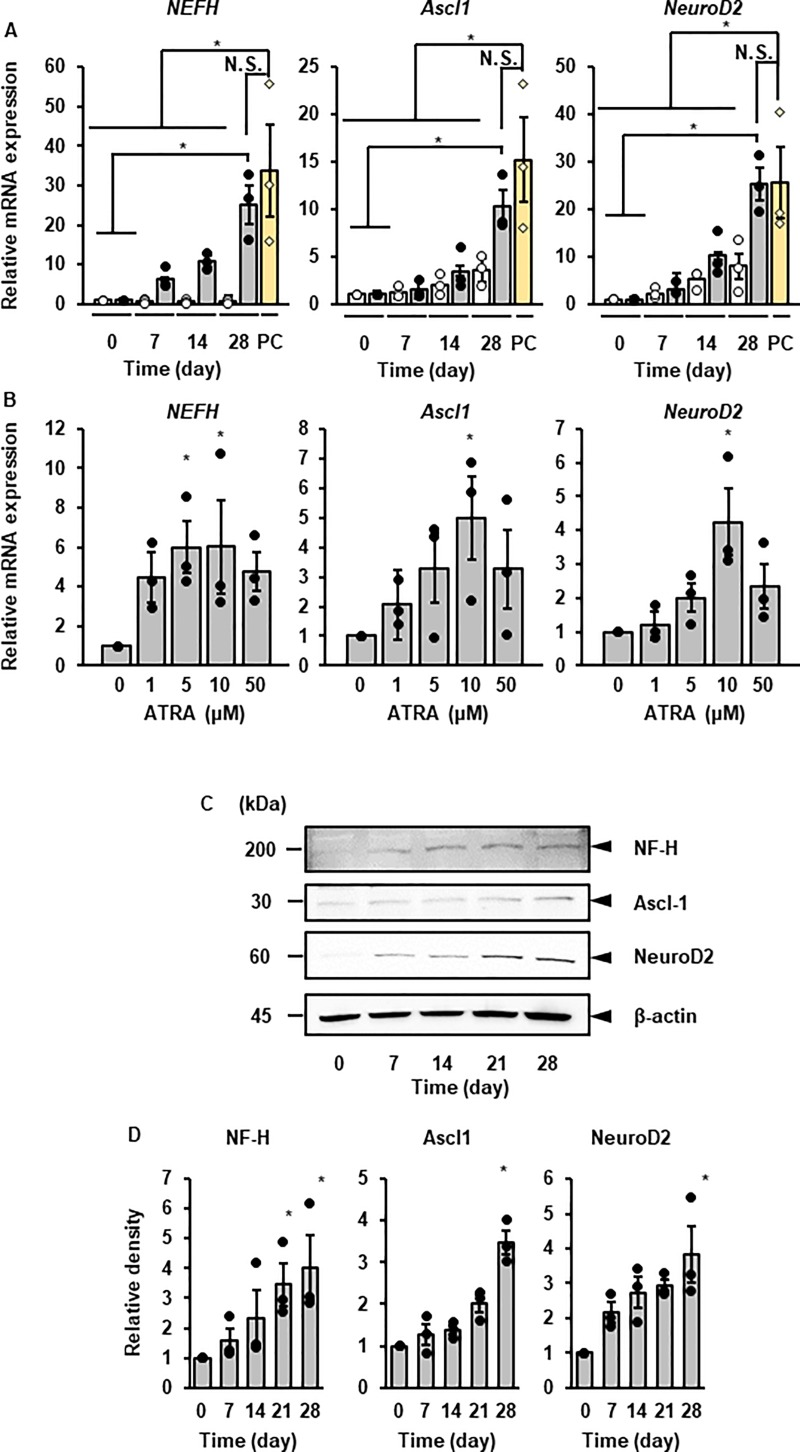
The effect of ATRA on the expression of neuronal marker mRNAs and proteins in canine DFATs.(A) Time-dependent changes in mRNA expression of the neuronal markers (NF-H, Ascl1, and NeuroD2) in ATRA-treated canine DFAT cells and positive control (PC; primary cultured neuron from canine cerebral cortex). DFATs were treated with (grey bar) and without (white bar) ATRA (10 μM). Data are shown as the mean ± standard error of three independent experiments. *P < 0.05. (B) The mRNA expression of NF-H, Ascl1, and NeuroD2 after 3 days of treatment with the indicated concentration of ATRA. Data are shown as mean ± standard error of three independent experiments. *P < 0.05, compared with 0 μM. (C) Representative images of protein expression of NF-H, Ascl1, and NeuroD2 after ATRA treatment. DFATs were treated with ATRA (10 μM). Cell lysate (10 μg protein) was applied to each lane. β-actin was used as an internal standard. (D) Relative density of the protein expression of NF-H, Ascl1, and NeuroD2 after ATRA. Data are shown as mean ± standard error of three independent experiments. *P < 0.05, compared with 0 day.